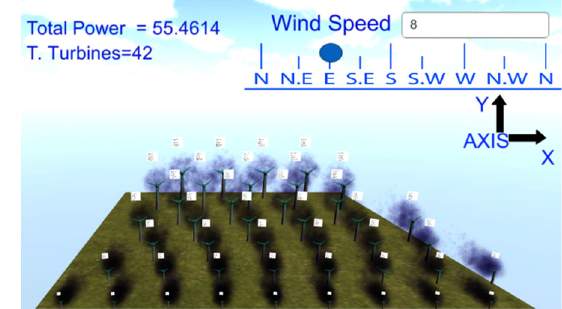
Fig. 5: Wind direction Front End user interactive